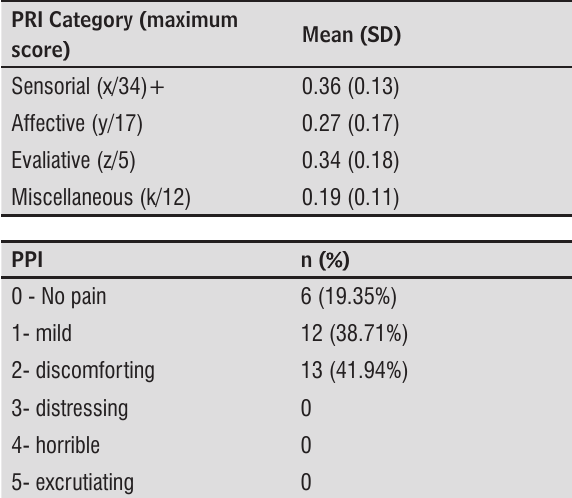
Table 3 - Participants’ Pain Rating Index (PRI) and Present Pain Intensity (PPI) score values (n =